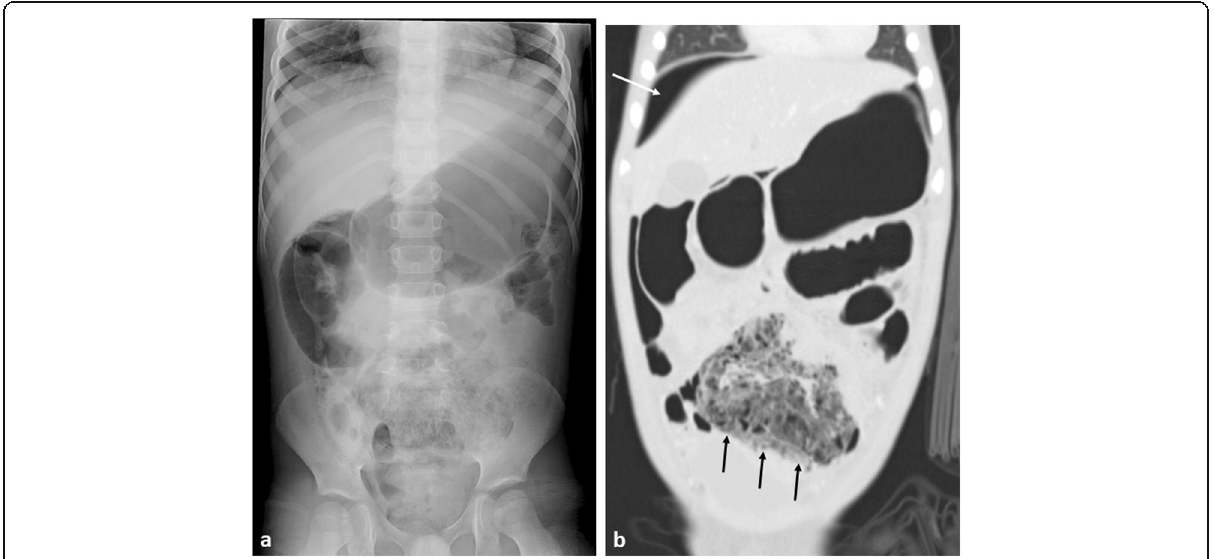
Fig. 14 A 6-year-old boy with small bowel Burkitt ’ s lymphoma. a Abdominal plain radiograph demonstrates gastric and small bowel dilatation with a mottled gas appearance within the pelvis. b Coronal CT imaging with lung windows, demonstrates free intra-abdominal gas, best seen superior to the liver (white arrow), with proximal bowel obstruction and perforation of a thick-walled ileal mass (black arrow)